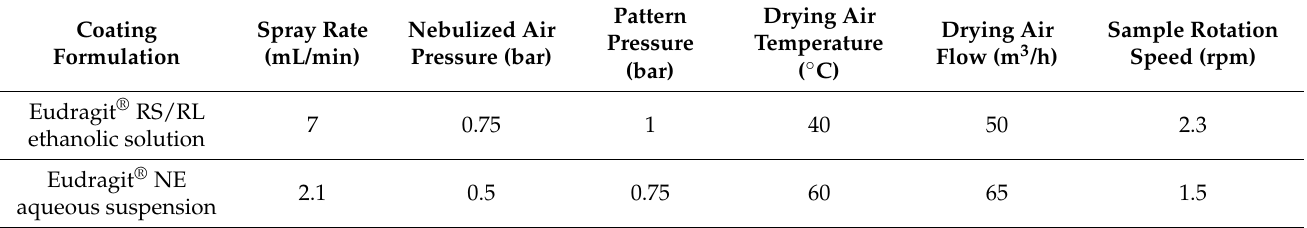
Table 1. Coating process